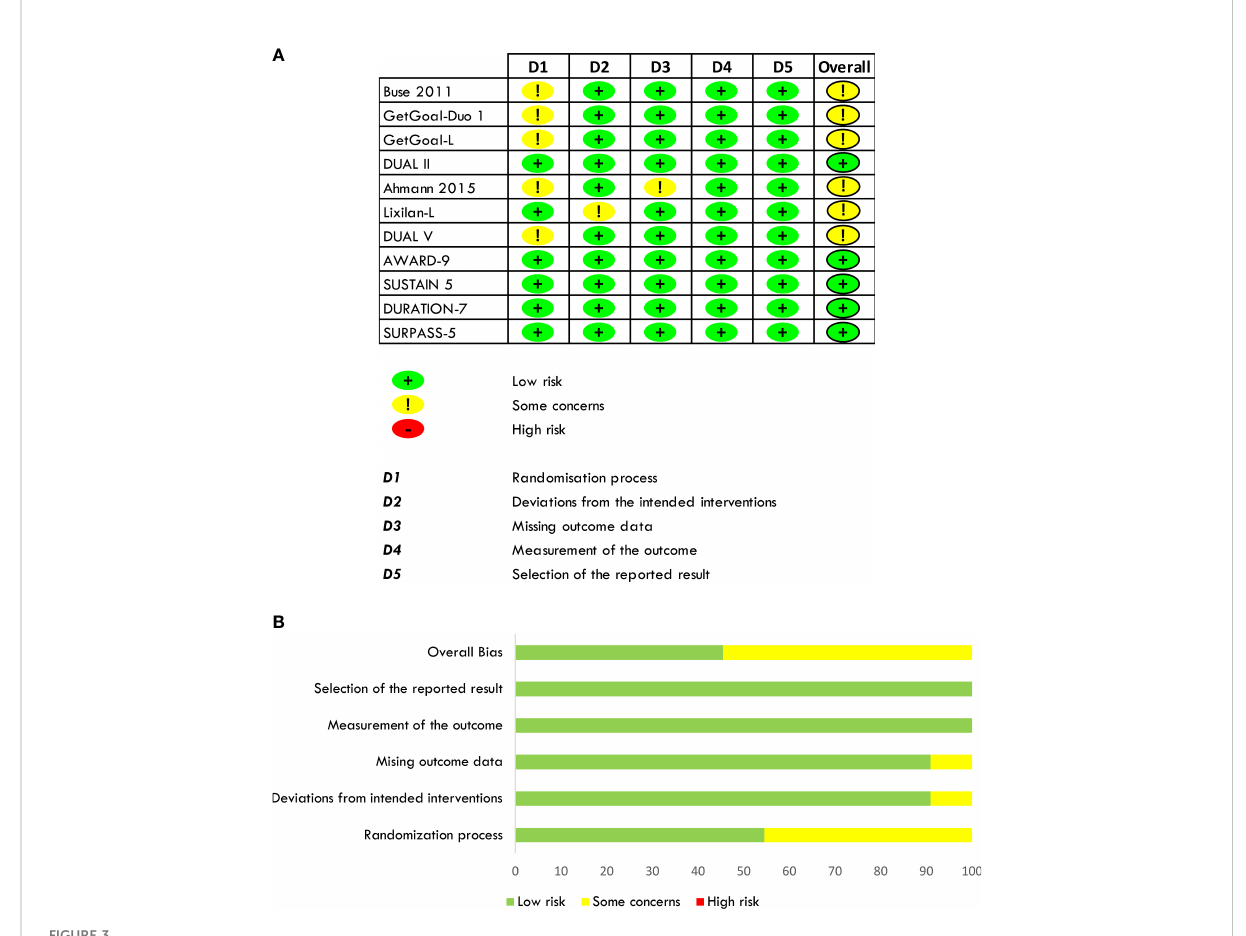
FIGURE 3 Quanti fi cation of the risk of bias of included studies (A, B)